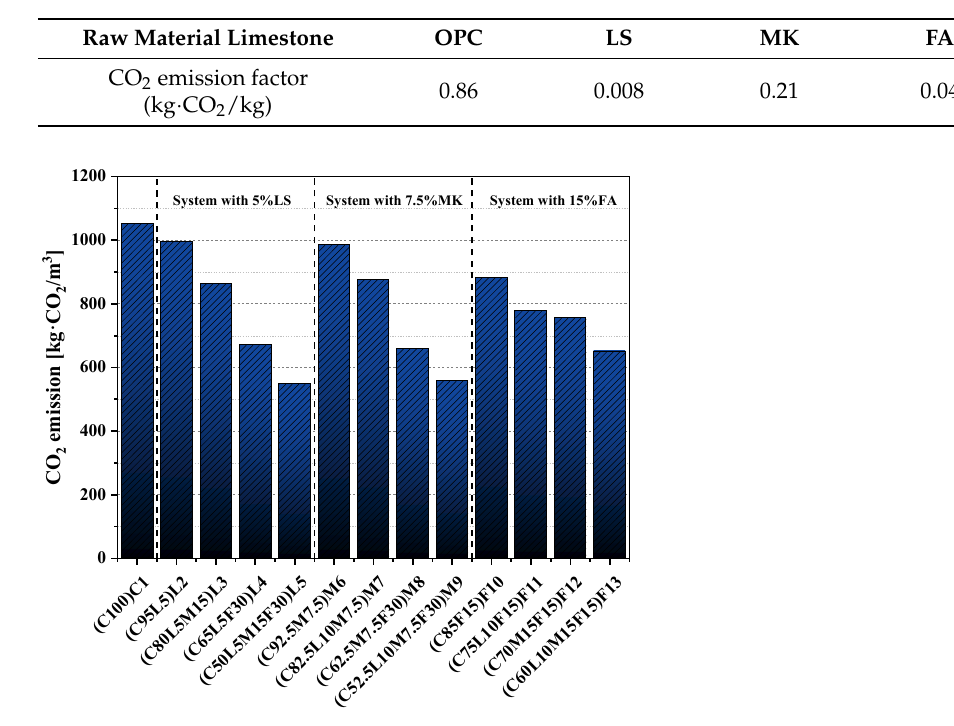
Table 4. CO 2 emission factor of materials [56].